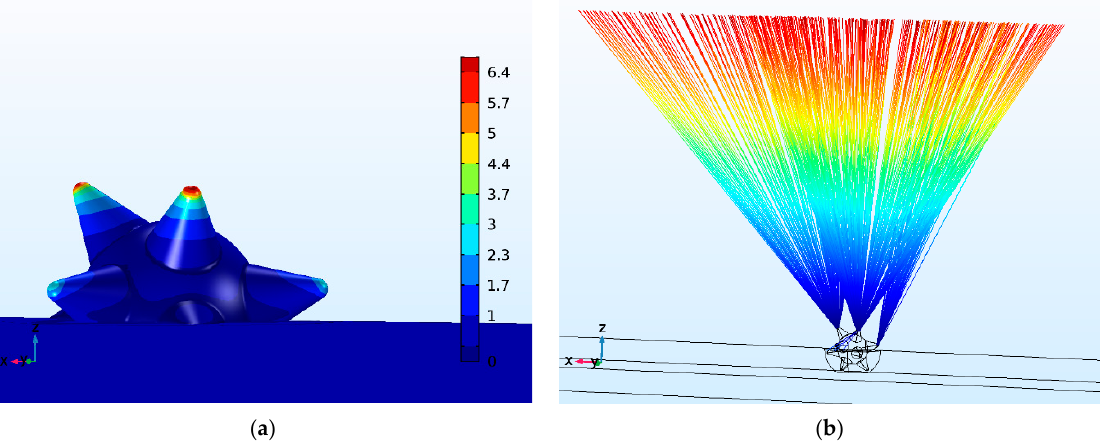
Figure 9. A map of the gain distribution ξ F of the electrostatic field on the surface of GNS embedded into the DLC film and its surroundings ( a ), the vector of an external uniform field with a strength F 0 is directed along the z -axis; results of modeling the trajectories of electrons emitted from the particular points of GNS spikes ( b ).